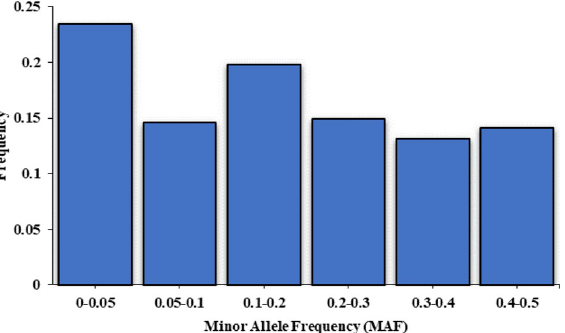
Figure 1. Distribution of minor allele frequencies (MAF) across the data set obtained by GBS in American mink.